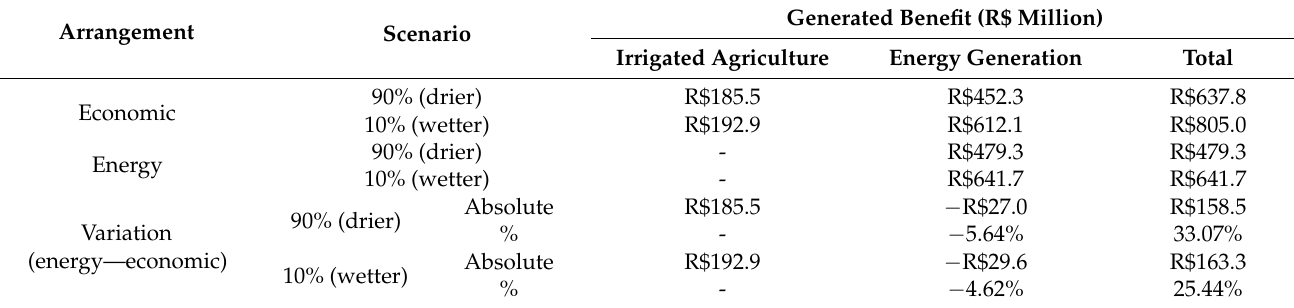
Generated Benefit (R$